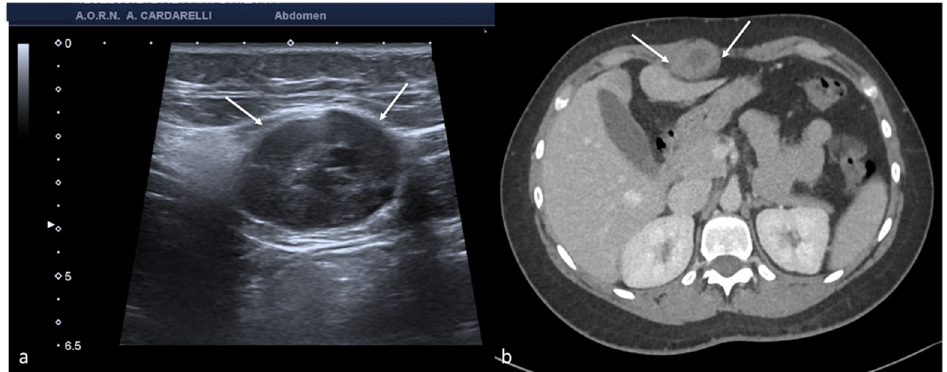
Figure 9. Abdominal wall endometriosis nodule. TSA–US axial scan ( a ) of the abdominal wall shows a 35 mm abdominal wall endometriosis nodule with hypoechoic content and well-defined margins (( a ), arrows). The nodule is enclosed in the muscular fascia along the right rectal abdomen. Contrast-enhanced axial CT image ( b ) shows heterogeneous enhanced mass in the right rectus sheath. The mass was subsequently proved to be abdominal endometriosis. Table 7. Endometriosis US diagnostic